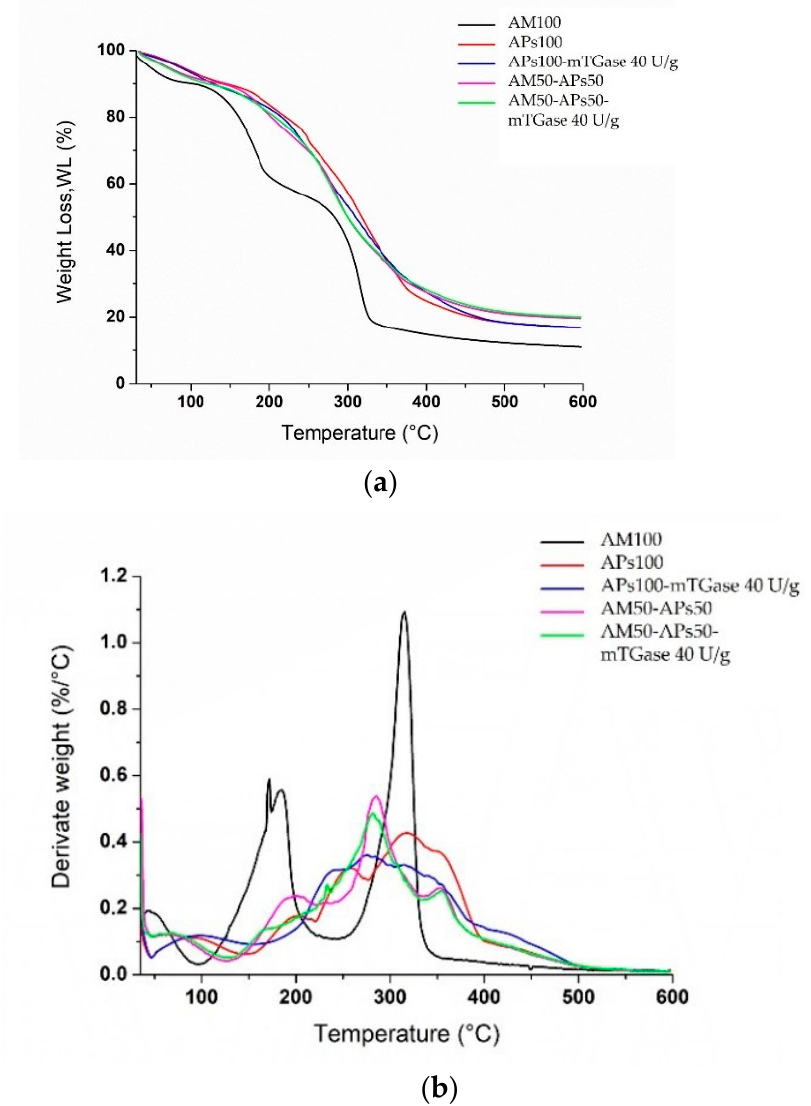
Figure 10. TGA ( a ) and DTG ( b ) curves of AM100-based films, blended films (APs50-AM50) treated or not by mTGase, APs100-based films in the absence and the presence of the enzyme.